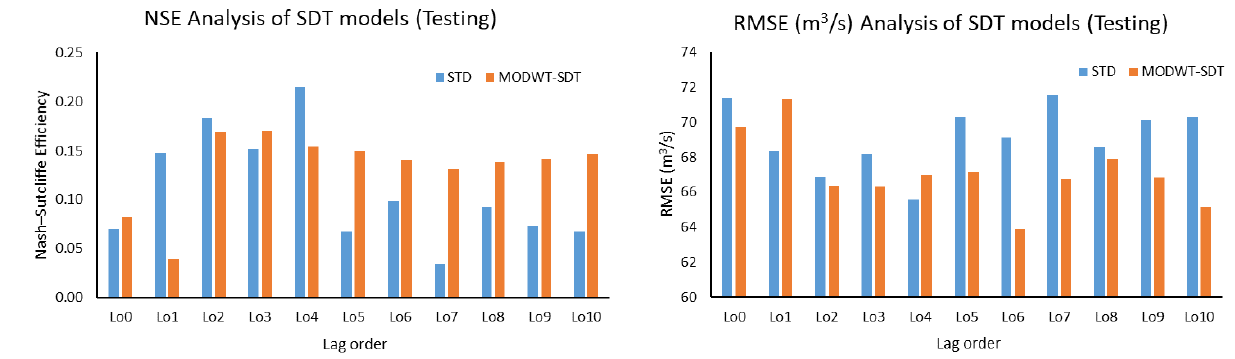
Figure 8. Performance evaluation of the SDT and MODWT-SDT models.